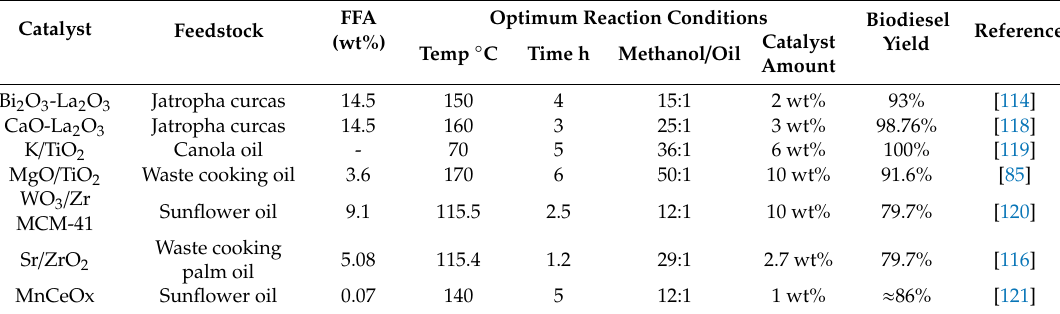
Table 3. Bifunctional heterogeneous catalysts for concurrent esterification and transesterification reactions.